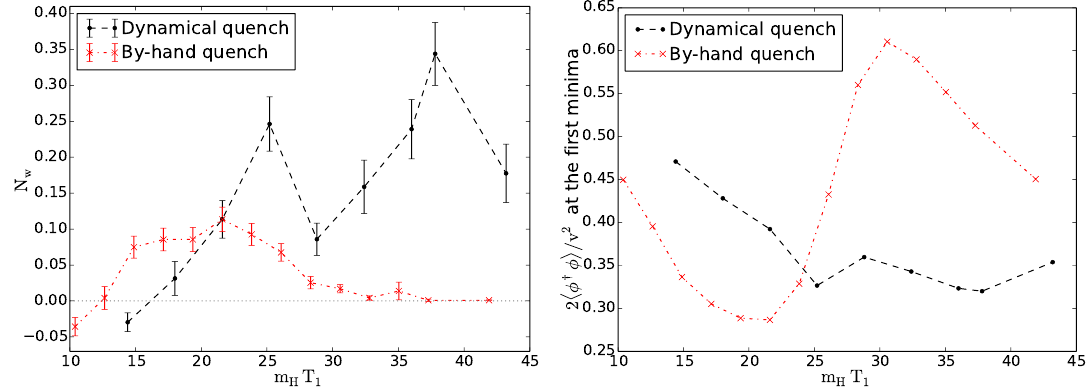
) to complete the transition. H